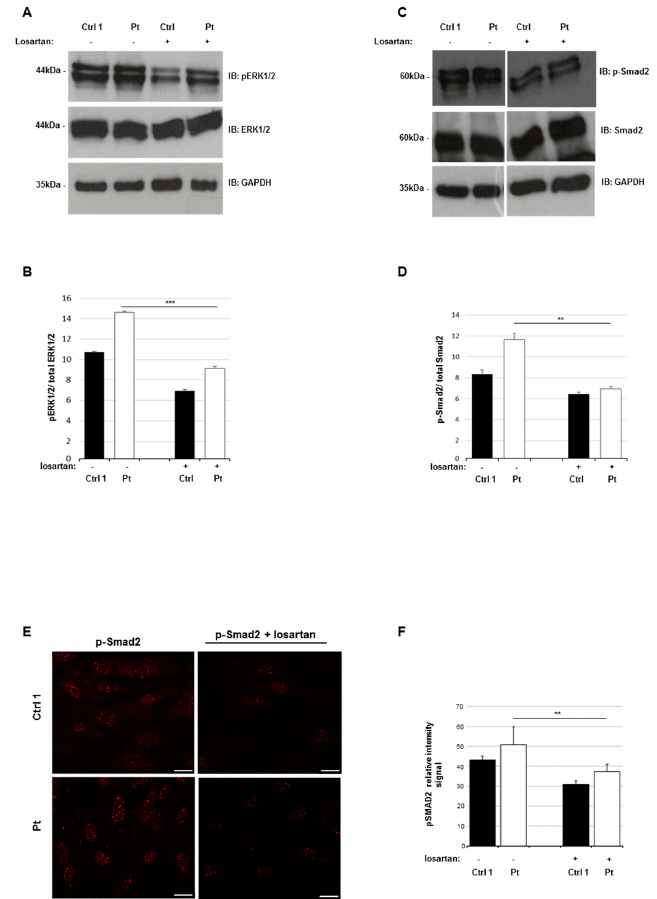
Figure 5. Losartan reduces the TGF-B signaling in patient’s lesional fibroblasts. ( A ) Cell lysates were obtained from skin fibroblasts after losartan incubation (200 μ M) for 14 days. Whole protein lysates were separated on 10% SDS-gel and subjected to immunoblotting with anti-ERK1/2, anti p-ERK1/2, and anti-GAPDH Abs. GAPDH was used as internal control. ( B ) Levels of p-ERK1/2 and ERK1/2 were quantified by densitometry using IMAGEJ analysis software. Relative p-ERK1/2 level was normalized compared to ERK1/2 level. Values are expressed as mean ± SEM (*** p < 0.01, n = 3). ( C ) Cell lysates were obtained from skin fibroblasts after losartan incubation (200 μ M) for 14 days. Whole protein lysates were separated on 10% SDS-gel and subjected to immunoblotting with anti-p-Smad2, anti p-Smad2 and anti-GAPDH Abs. GAPDH was used as internal control. ( D ) Levels of p-Smad2 and Smad2 were quantified by densitometry using IMAGEJ analysis software. Relative p-Smad2 level was normalized compared to Smad2 level. Values are expressed as mean ± sd (** p < 0.03, n = 3). ( E ) Confocal study showed the nuclear localization of p-Smad2 in the fibroblasts of patient (Pt) and control (Ctrl) lines, with or without Losartan incubation (200 μ M) for 14 days, and staining with anti-p-Smad2 antibody. White line, scale bar 1 μ m. ( F ) We analyzed the intensity of the Alexafluor 568 signal by measuring the relative intensity of pixels representative for each regions of interest (ROI) corresponding to a single cell by LAS-X software. The graph reports means ± s.d. of p-Smad2 intensity values from 100 cells for each experiment (** p < 0.03, n =